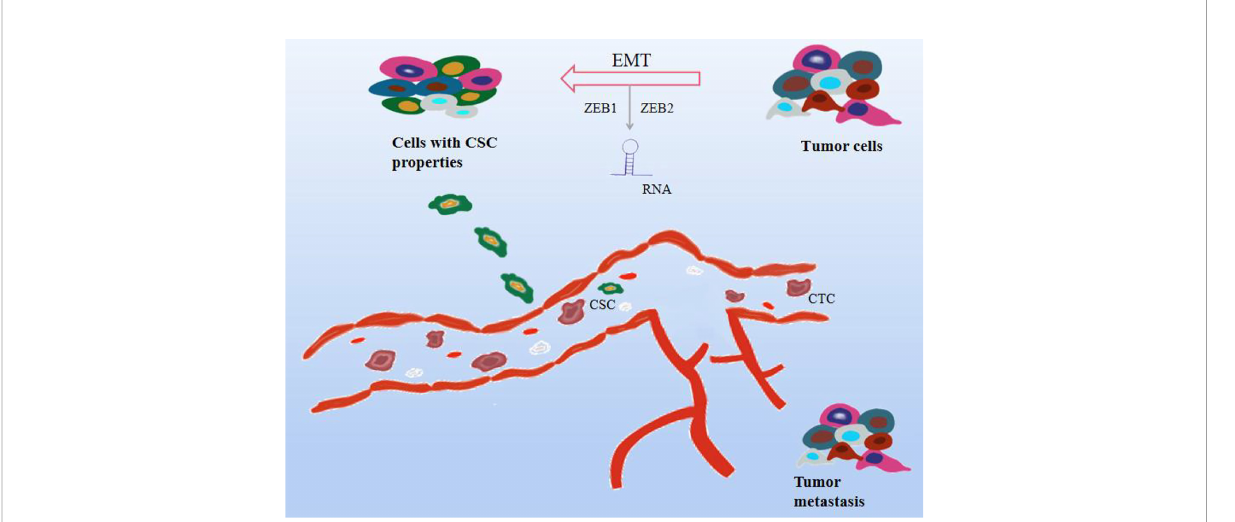
FIGURE 5 Effect mechanism of natural compounds on tumor metastasis. Cancer cells can proliferate inde fi nitely, lose their original cell function, and migrate easily. As the blood circulates, they cause cancer to metastasize. Natural compounds can inhibit tumor metastasis and exert anticancer effects through a variety of mechanisms, including 1. Epithelial-mesenchymal transition (EMT); 2. Circulating tumor cells (CTC); 3. Cancer stem cells (CSC) 4.RNA